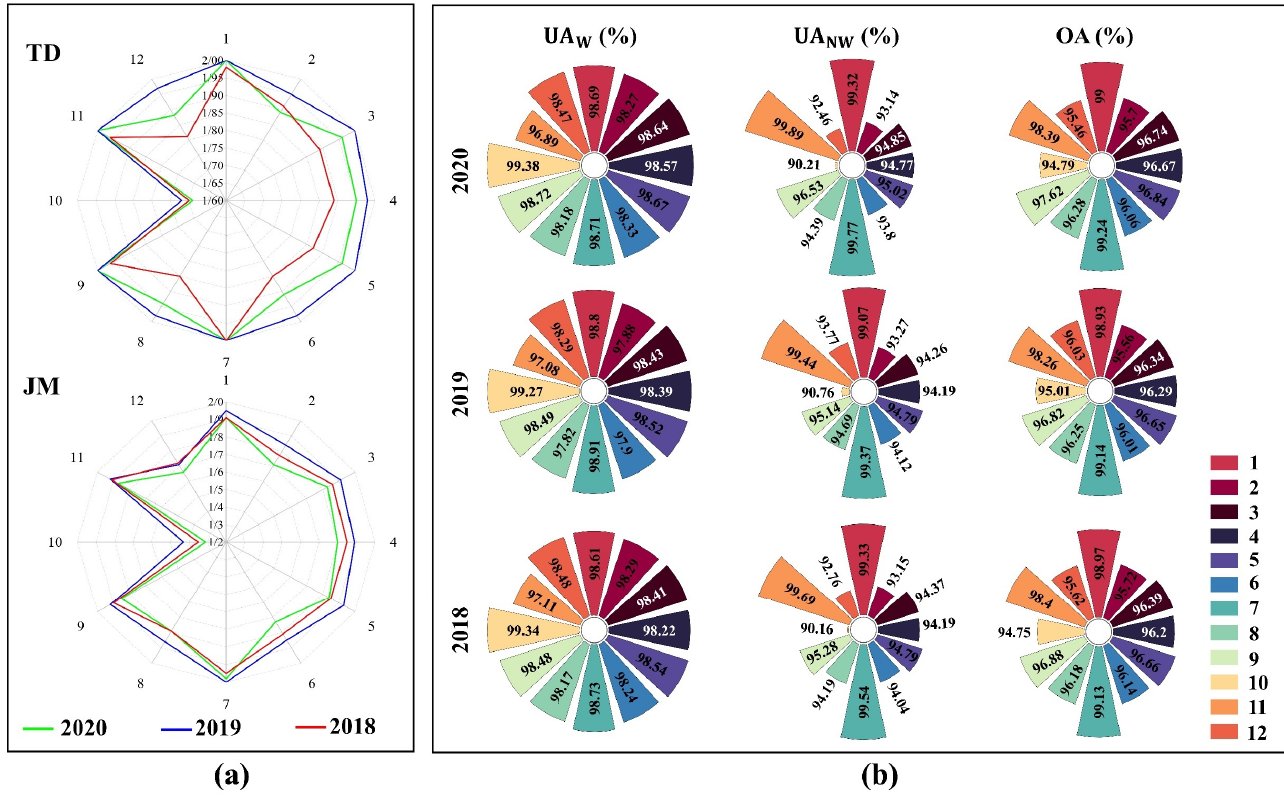
Figure 4. Performance analysis of 12 different WMRs over the study area: ( a ) separability analysis of target classes (water and non-water) in different feature spaces using JM and TD measures; ( b ) performance evaluation of different WMRs based on UA w , UA nw , and OA. Different methods are shown with their corresponding numbers in Table 2.